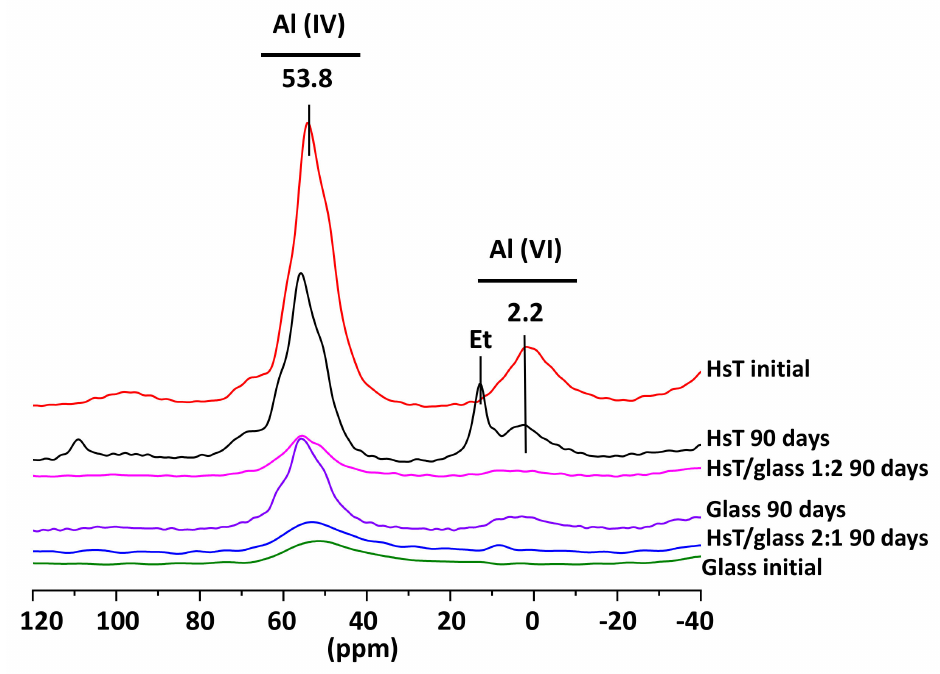
Figure 5. NMR of the 29 Al cores of the initial HsT and glass waste and the binary mixtures at 90 days (Et =